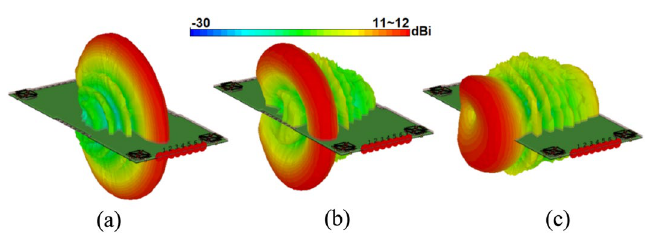
Figure 29. Radiation beam-steering of the phased array (placed at top-edge) at ( a ) 0, ( b ) 30, and ( c ) 60 degrees.